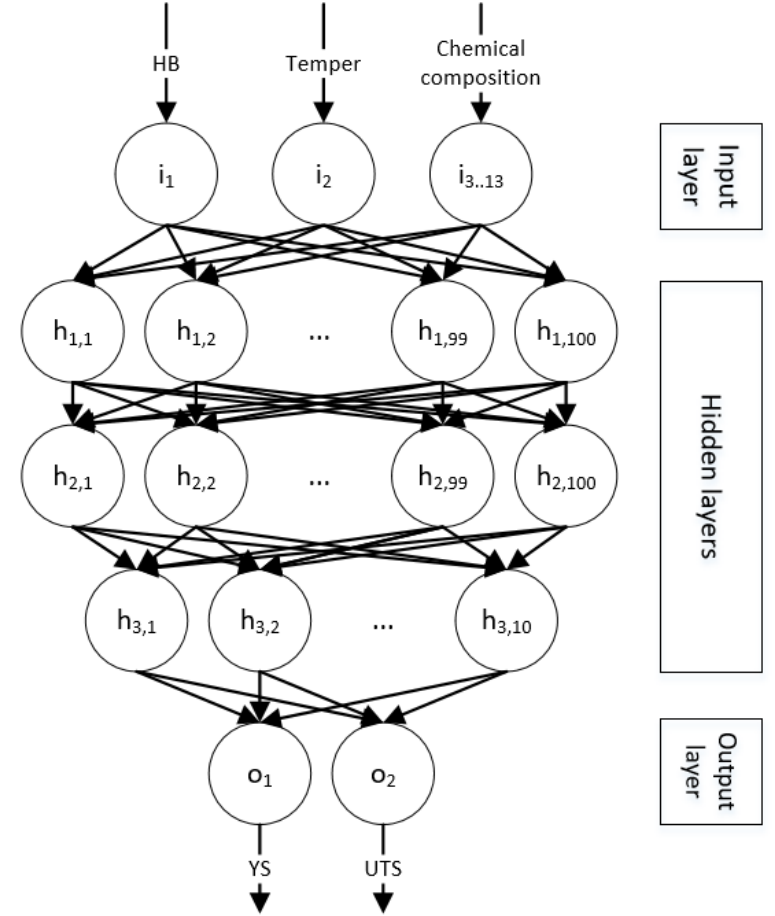
Figure 3. Artificial neural network